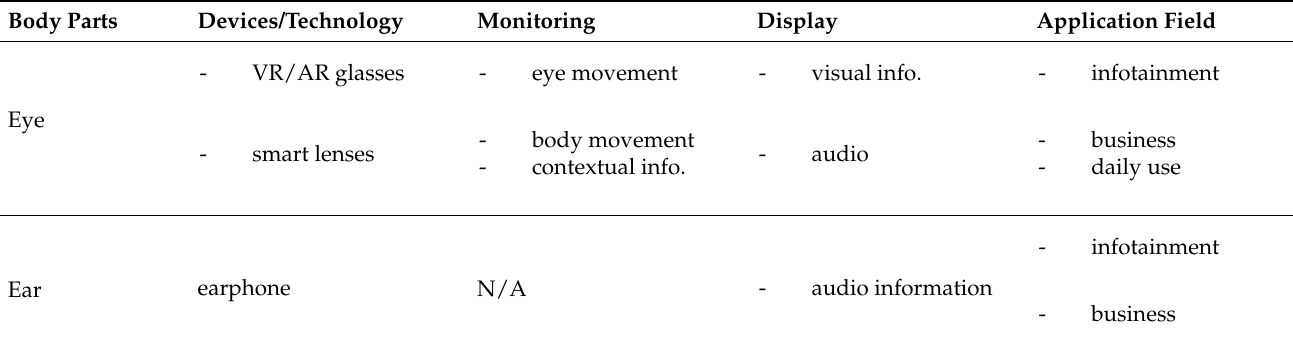
Table 1. Classification of wearable technology and